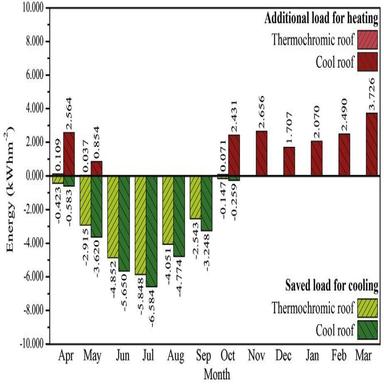
Difference between the cumulative energy load per meter square of the thermochromic or cool roof, relative to the dark roof, for each simulated month.